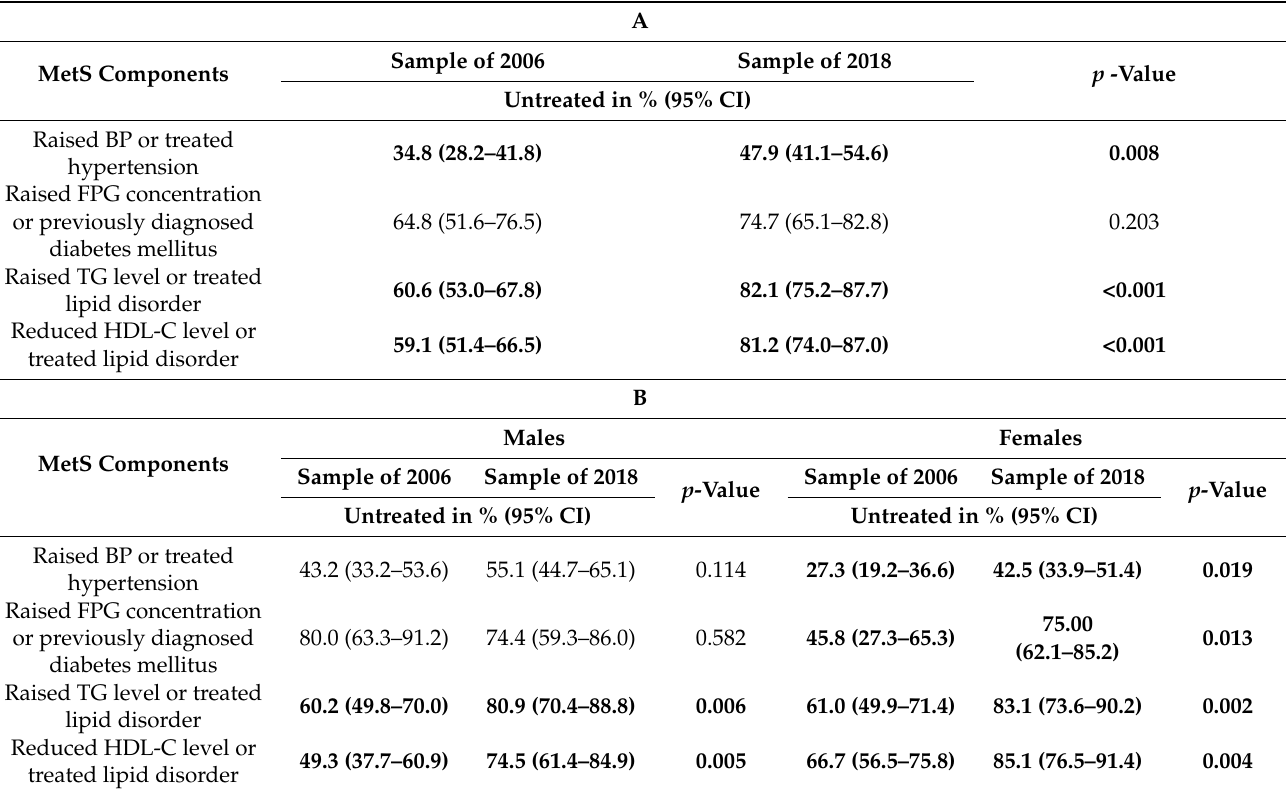
Table 5. Change in the prevalence of untreated individuals for the four treatable components of metabolic syndrome (MetS) in study populations (A) and by sex